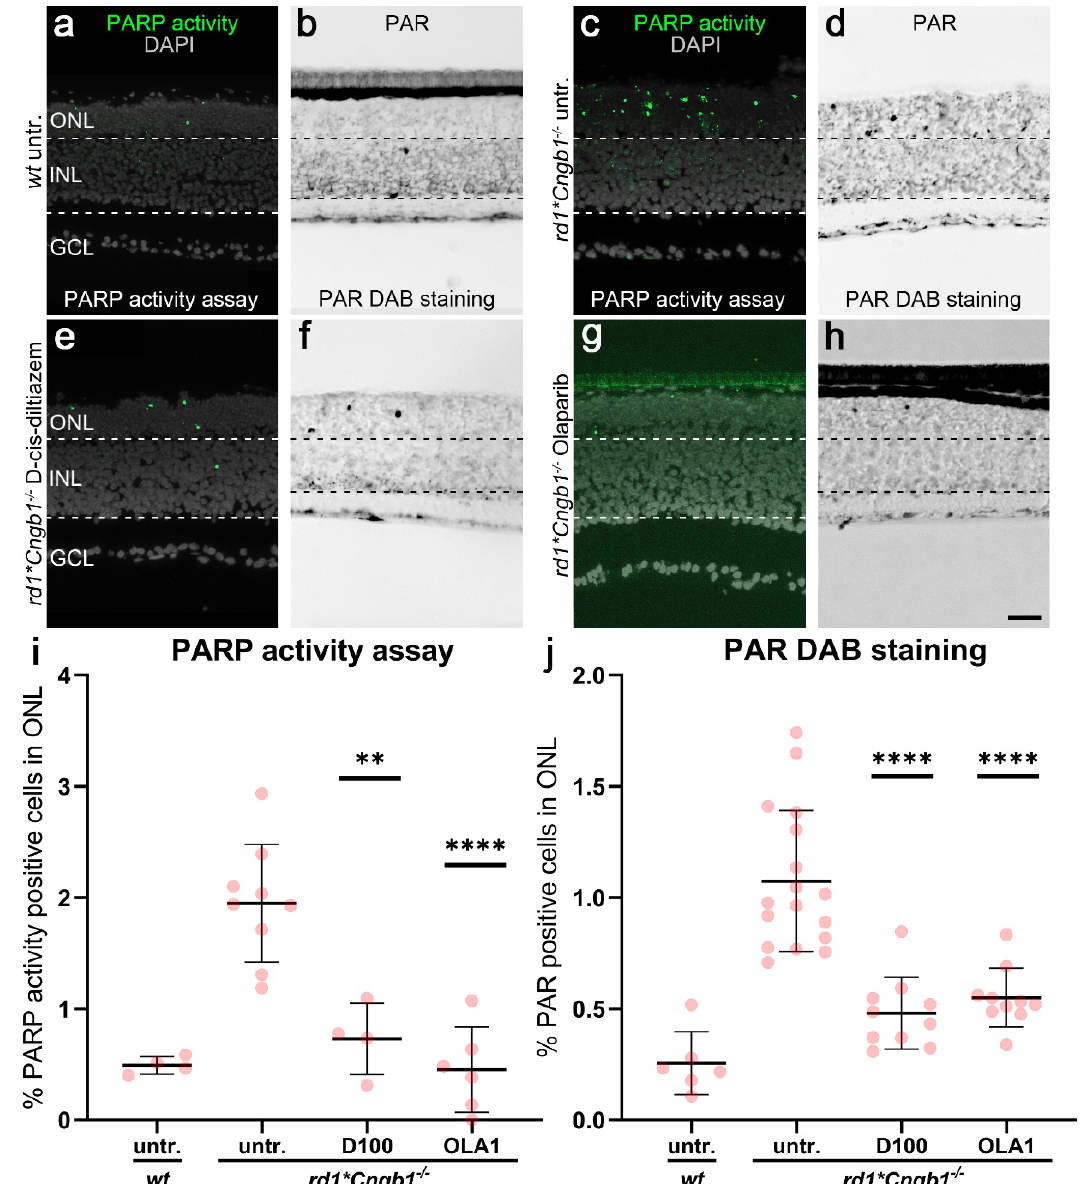
Figure 5. Effects of D-cis-diltiazem and Olaparib on PARP activity and PAR accumulation in rd1*Cngb1 − / − double-mutant retina. The PARP activity assay (green) and immunostaining for PAR (black) were performed on wt ( a , b ) and rd1*Cngb1 − / − retina ( c – h ). DAPI (grey) was used as nu- clear counterstaining. Untreated rd1*Cngb1 − / − retina (untr.; c , d ) was compared to retina treated